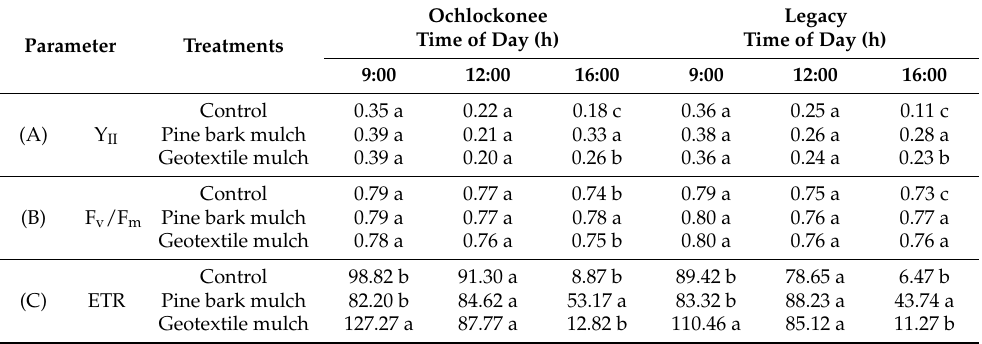
Table 1. Mean parameters of chlorophyll fluorescence: (A) photochemical quantum yield of photo- transport rate (ETR).